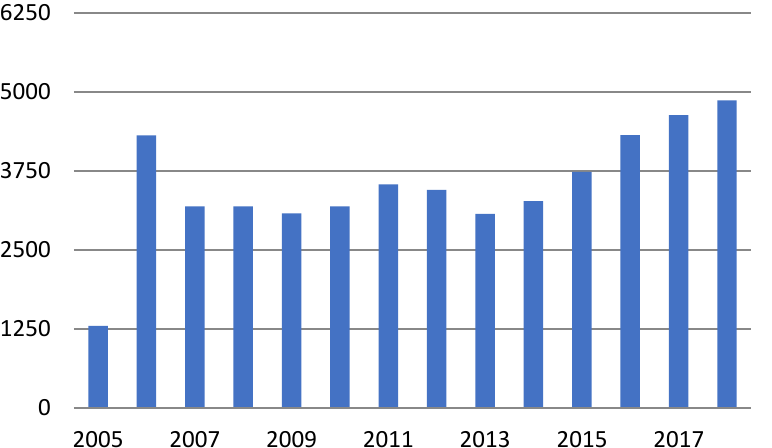
Figure 1. Evolution of same-sex marriages (absolute number). Source: elaboration based on the natural movement of the population (NMP).